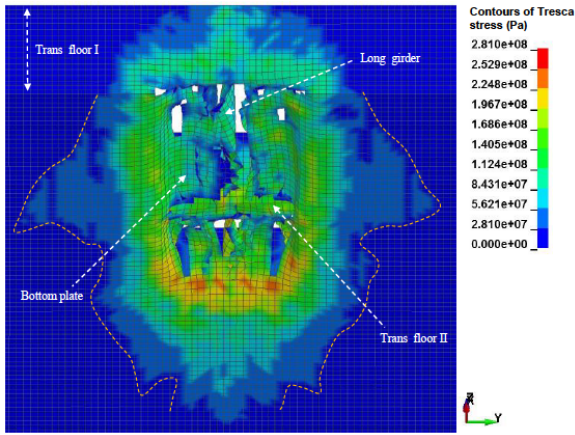
Figure 15: Structural acceleration under grounding action. The se- lected obstruction: idealised shoal.